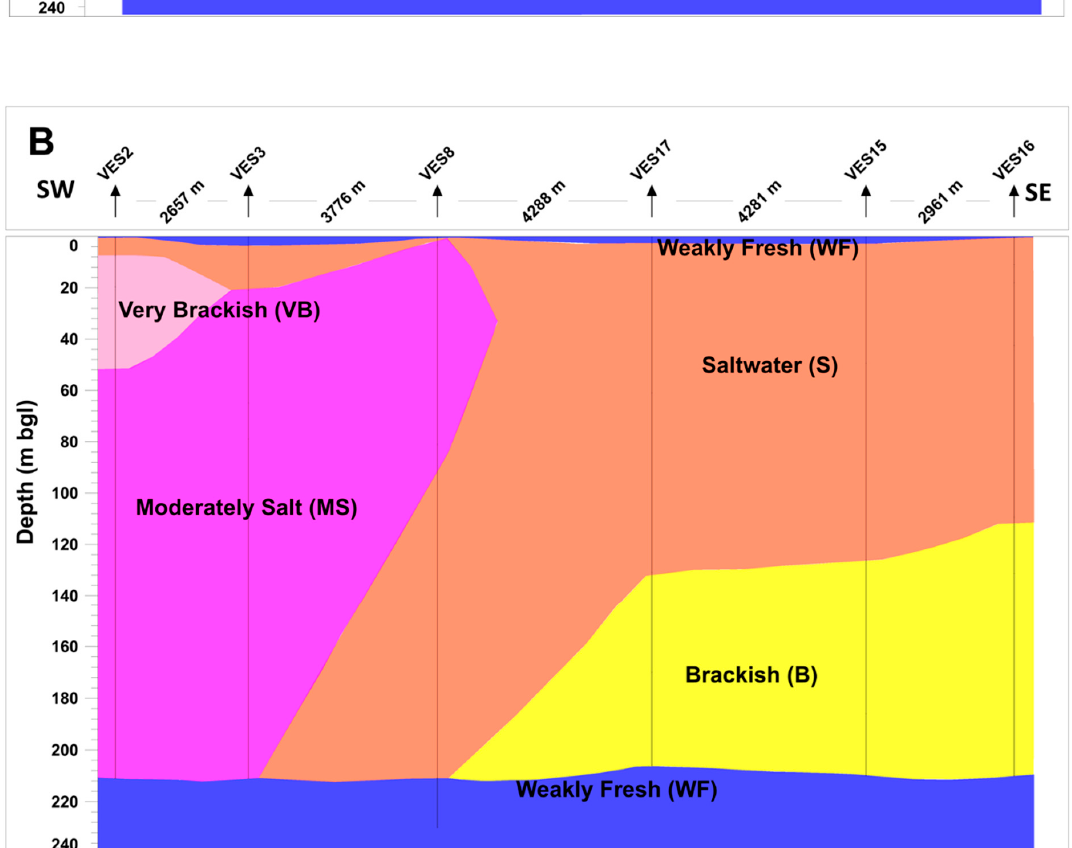
Figure 8. Water-salinity-class profiles based on VES in the southern part of the study area. The profiles ( A , B ) are directed SW-NE and SW-SE, respectively. The location of the VES was shown in Figure 1.